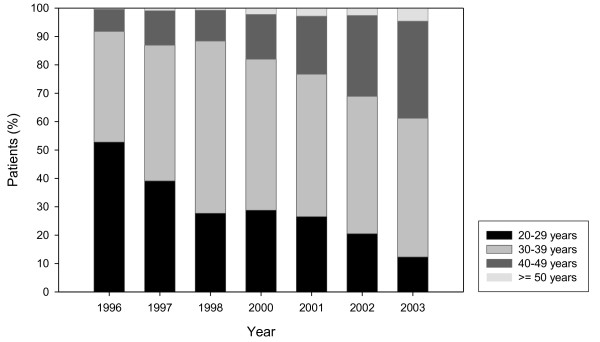
Age trends of the MMT population in the canton of Basel-City, Switzerland, 1996 to 2003.